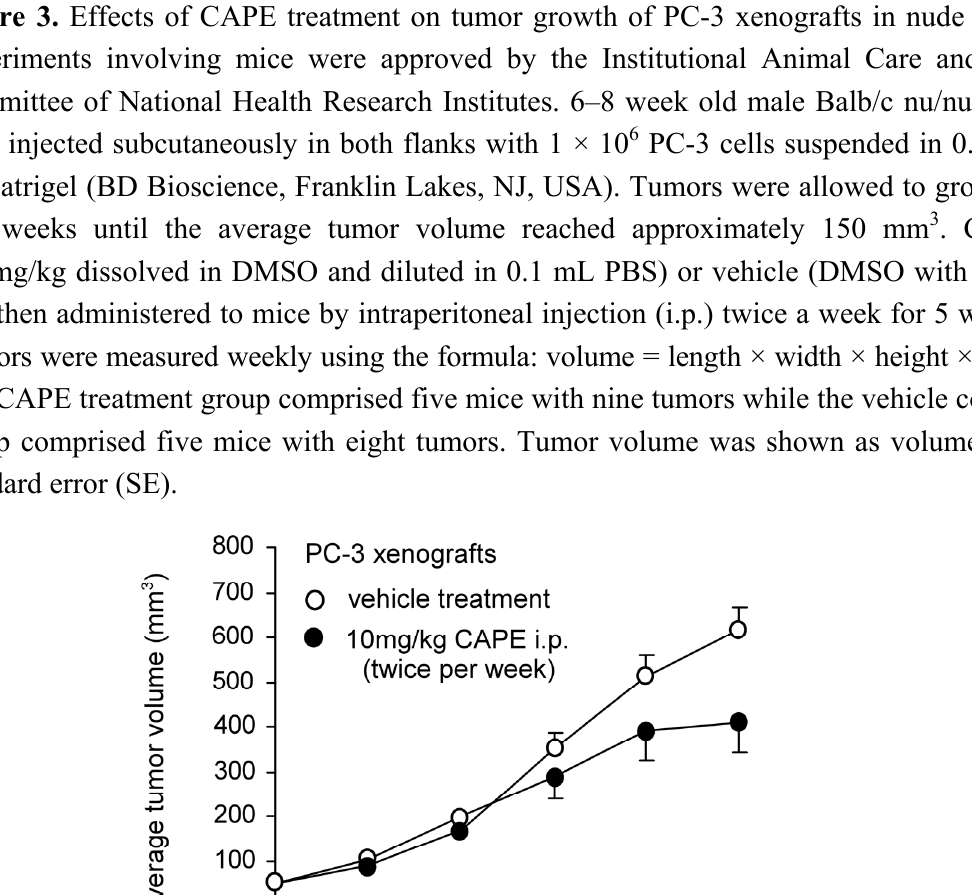
Figure 3. Effects of CAPE treatment on tumor growth of PC-3 xenografts in nude